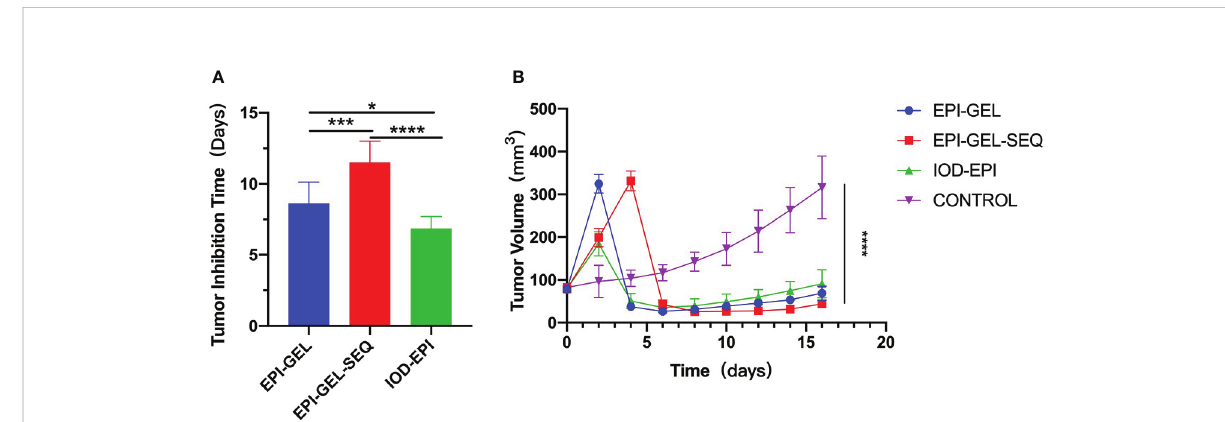
FIGURE 3 Tumor-bearing mice were monitored for tumor growth and tumor inhibition time (two successive measurements of tumor volume larger than before) after local injection. * p < 0.0332, ** p < 0.0021,*** p < 0.0002, **** p < 0.0001 (one-/two-way ANOVA with Tukey ’ s test). Data shown are the mean + SEM of the tumor inhibition time (A) and tumor volume (B) . n = 8/group.